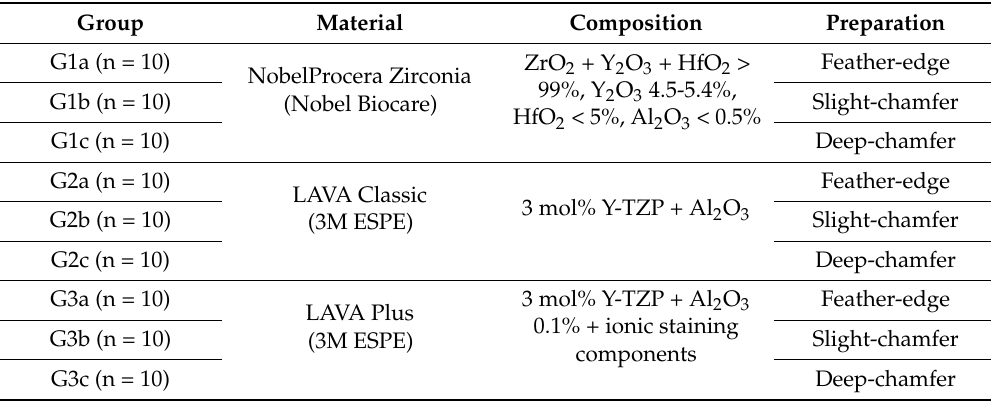
Table 1. Tested materials divided in groups, their compositions, and marginal preparations. All the groups were tested as received by manufacturers and after simulated artificial chewing for 1 year. Group Material Composition